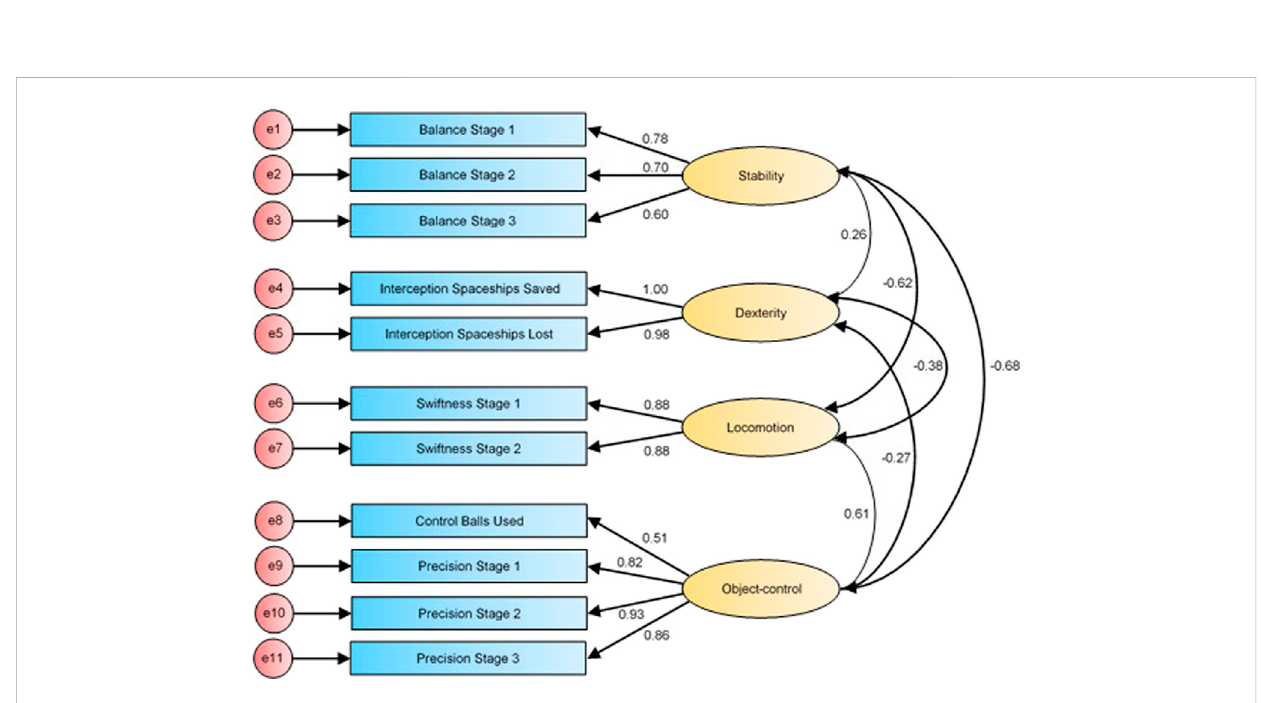
FIGURE 2 First-order factor structure of the GMCA (re-speci fi ed fi t; Model